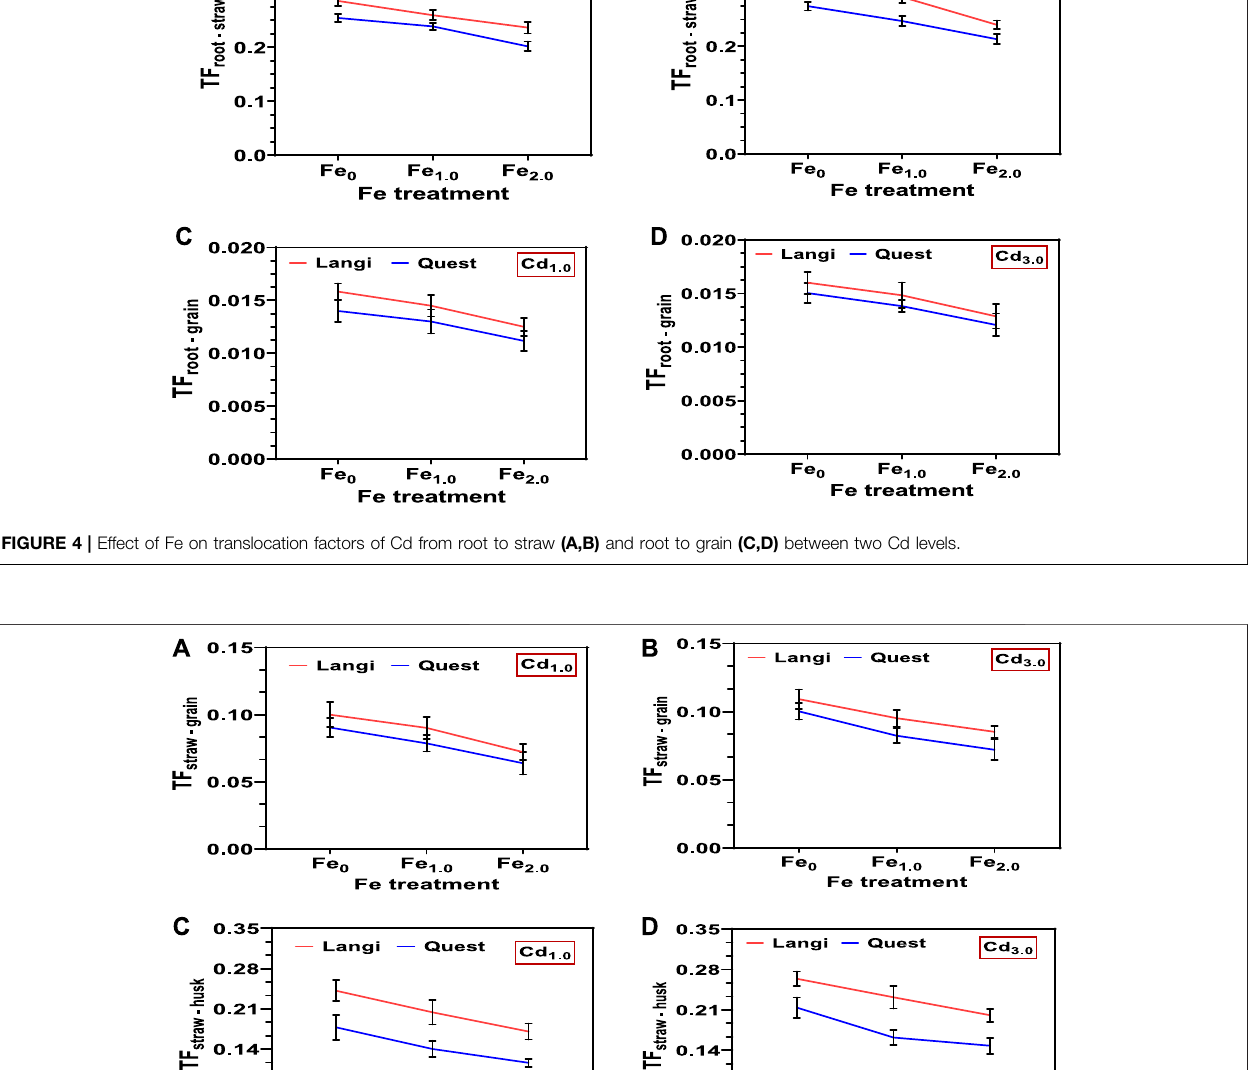
Frontiers in Environmental Science |